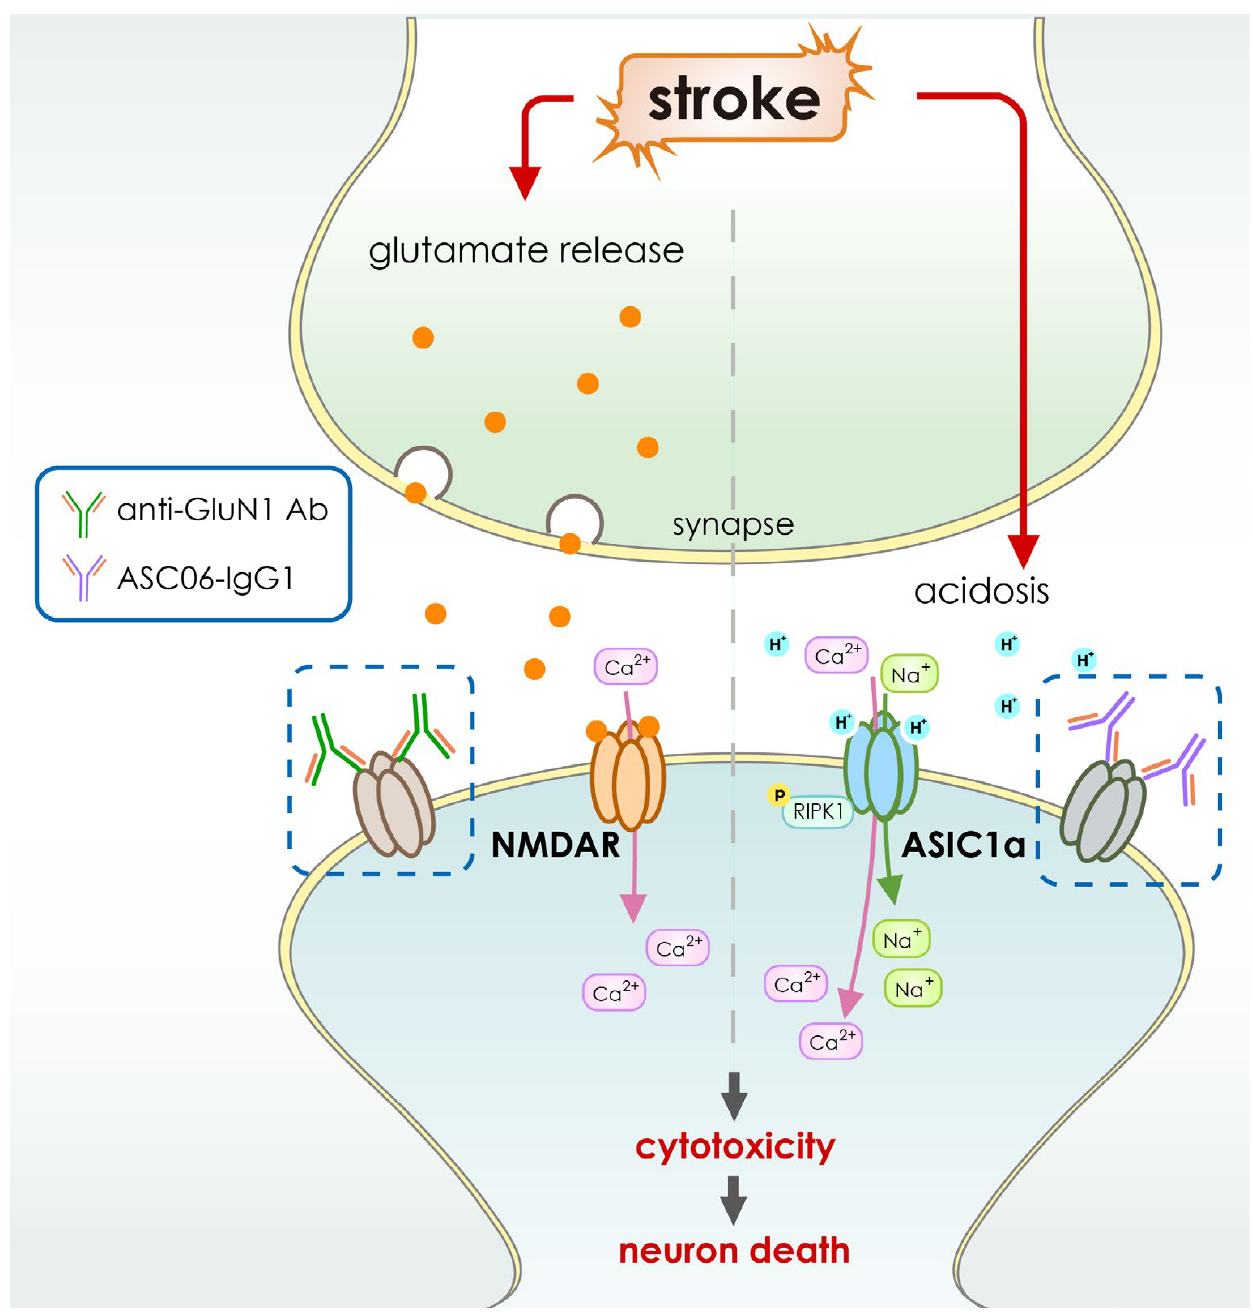
Figure 4. Schematic illustration for the function of ASIC1a or NMDAR in the development of stroke. Acidosis caused by anaerobic glycolysis is a common side effect of stroke. When pH levels drop after stroke, ASIC1a is activated, allowing calcium to flood the cell, creating an improper ionic balance and osmotic pressure. On the other hand, glutamate is the chief excitatory neurotransmitter in the central nervous system and displays critical roles in synaptic communications and flexible synaptic plasticity. However, the extensive and rapid accumulation of glutamate at the synaptic cleft after ischemic stroke can lead to over-excitation of the NMDARs (N-methyl-D-aspartate receptors), which can eventually be lethal to neurons. Both of the membrane-originated pathological events lead to edema and depolarization, which in neurons causes massive excitotoxicity from increased intracellular calcium ions and eventually, inflammation, hence ischemia injury. Inhibition of the ASIC1a or GluN1 with antibody-based drugs can reverse the neuronal death and protect against cerebral